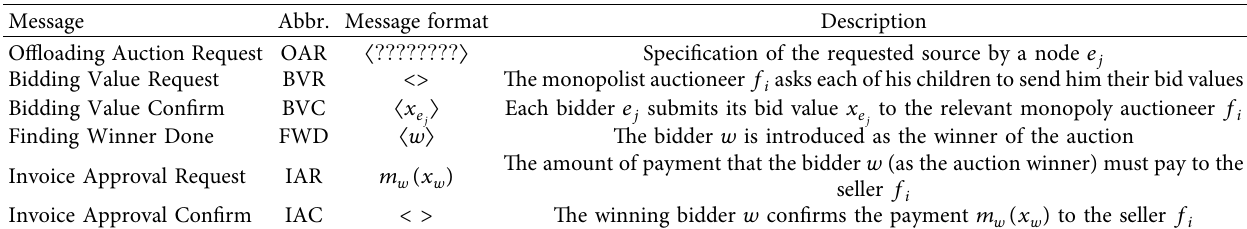
Figure 2: Te sequence diagram (workfow) of Table 2: Te specifcation of messages in the proposed mechanism.